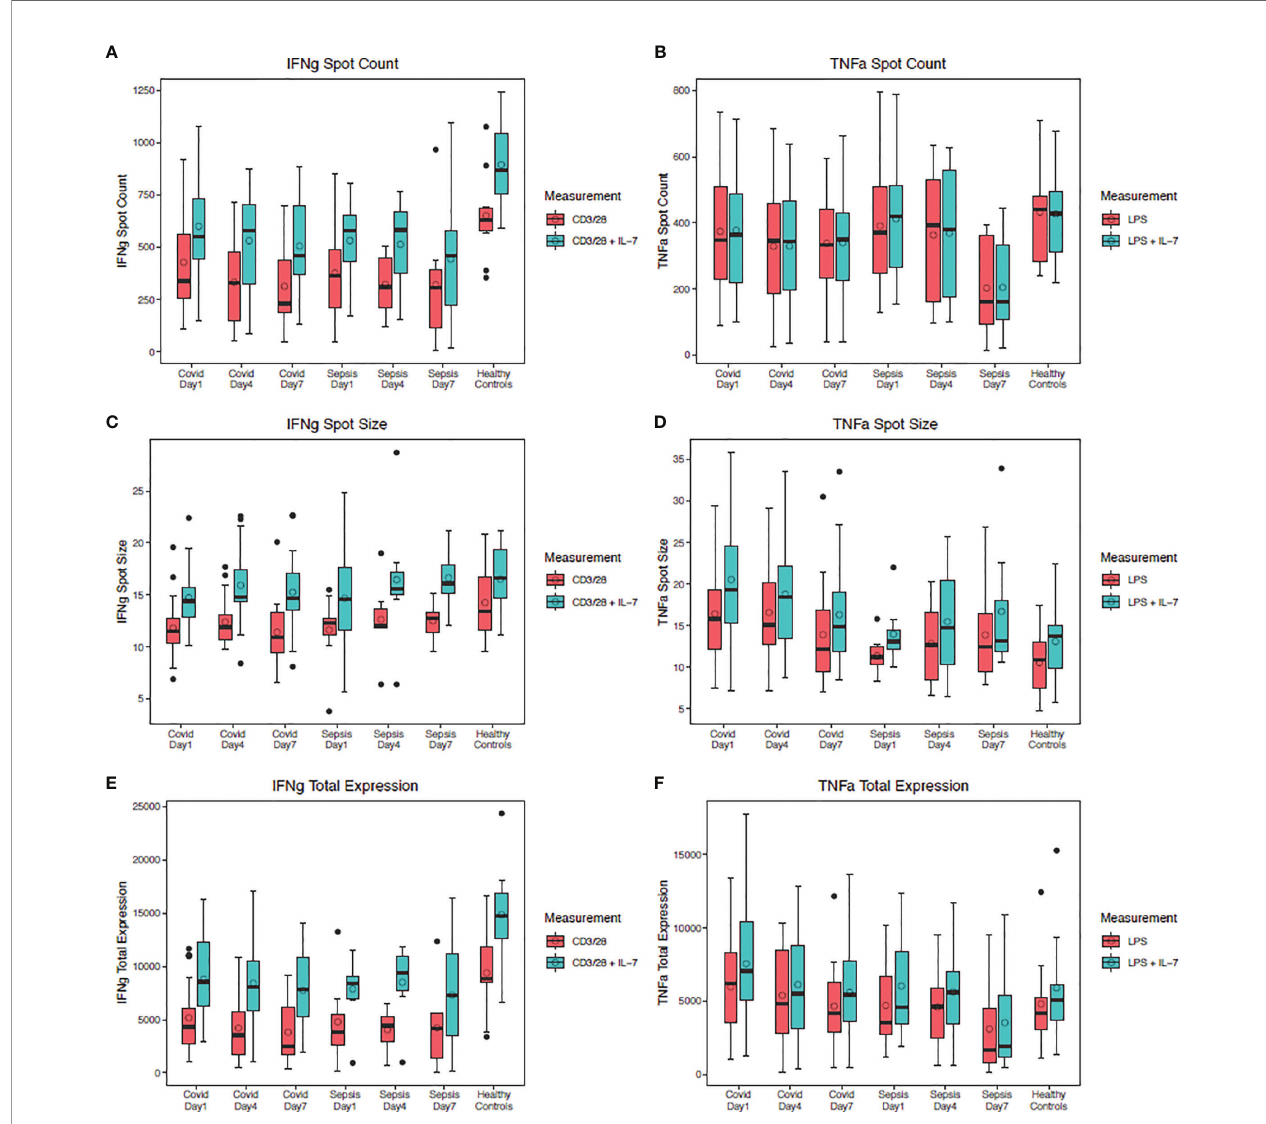
FIGURE 3 | TNF-alpha and IFN-gamma production in stimulated peripheral blood mononuclear cells. Four days after SARS-CoV-2 or bacterial sepsis, interferon (IFN)-gamma production in response to antiCD3/CD28 with IL-7 stimulation was signi fi cantly reduced compared with healthy controls (p=0.02 and p=0.04, respectively). Tumor necrosis factor (TNF)-alpha production in response to LPS stimulation with and without IL-7 stimulation was similar among all groups at all time points (all p>0.05). (A) IFN-gamma spot count over time with and without IL-7 stimulation. (B) TNF-alpha spot count over time with and without IL-7 stimulation. (C) IFN-gamma spot size over time with and without IL-7 stimulation. (D) TNF-alpha spot size over time with and without IL-7 stimulation. (E) IFN-gamma total expression over time with and without IL-7 stimulation. (F) TNF total expression over time with and without IL-7 stimulation. Data are presented as median values (bars) with interquartile ranges (boxes), mean values (circles within boxes), maximum and minimum values excluding outliers (whiskers), and outliers (circles outside whiskers), with outliers de fi ned as being 1.5 times the interquartile range beyond the 25th or 75th percentile. Groups were compared by generalized estimating equations with p-values corrected for multiple comparisons by the Benjamini-Hochberg procedure. At each time point, all available values (as listed in Supplemental Table 2 ) were included in all statistical tests for 30 SARS-CoV-2 patients, 10 bacterial sepsis patients, and 10 healthy control patients. D, day; CD, cluster of differentiation; IL,